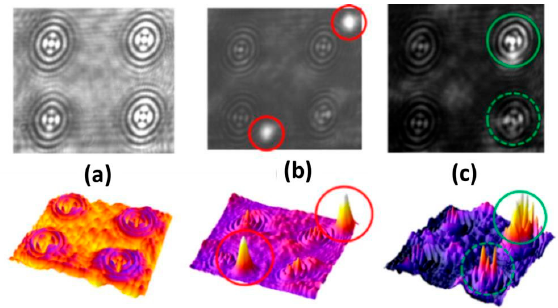
Figure 8. Configuration Com 3 : individually addressable configurations were realized by flexibly positioning SLM-generated needle beams (i.e. , single-maximum Bessel beams) on the elements of a 4 × 4 MEMS axicon array (pitch: 1 mm). The axicons were illuminated by an approximated plane wave ( a ), two arbitrarily displaced needle beams of different intensity ( b ), and the same two sub- beams centered at two selected axicons ( c ).